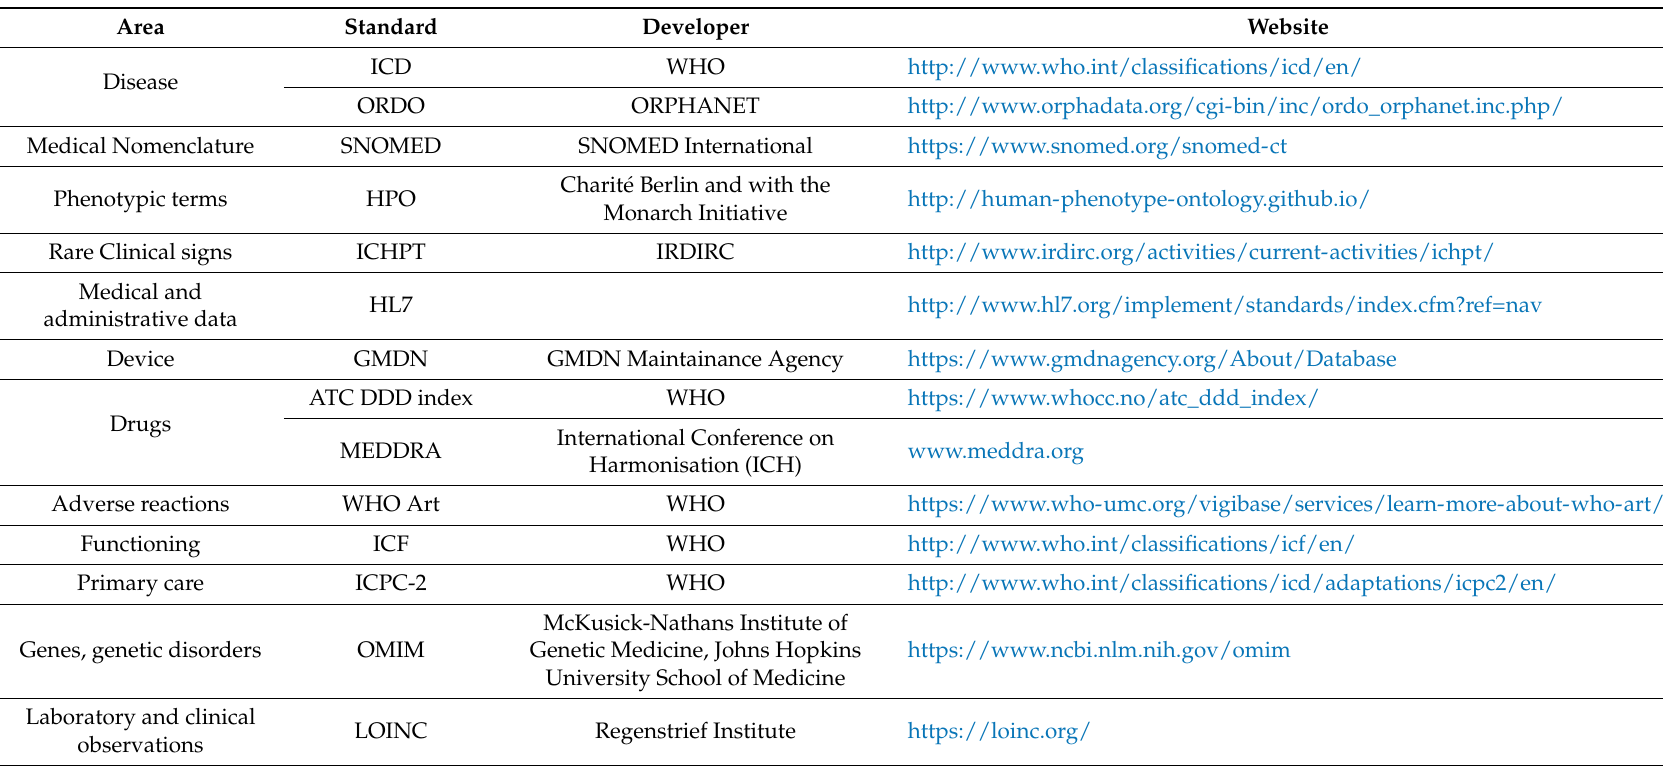
Table 1. Existing international standards used in the biomedical